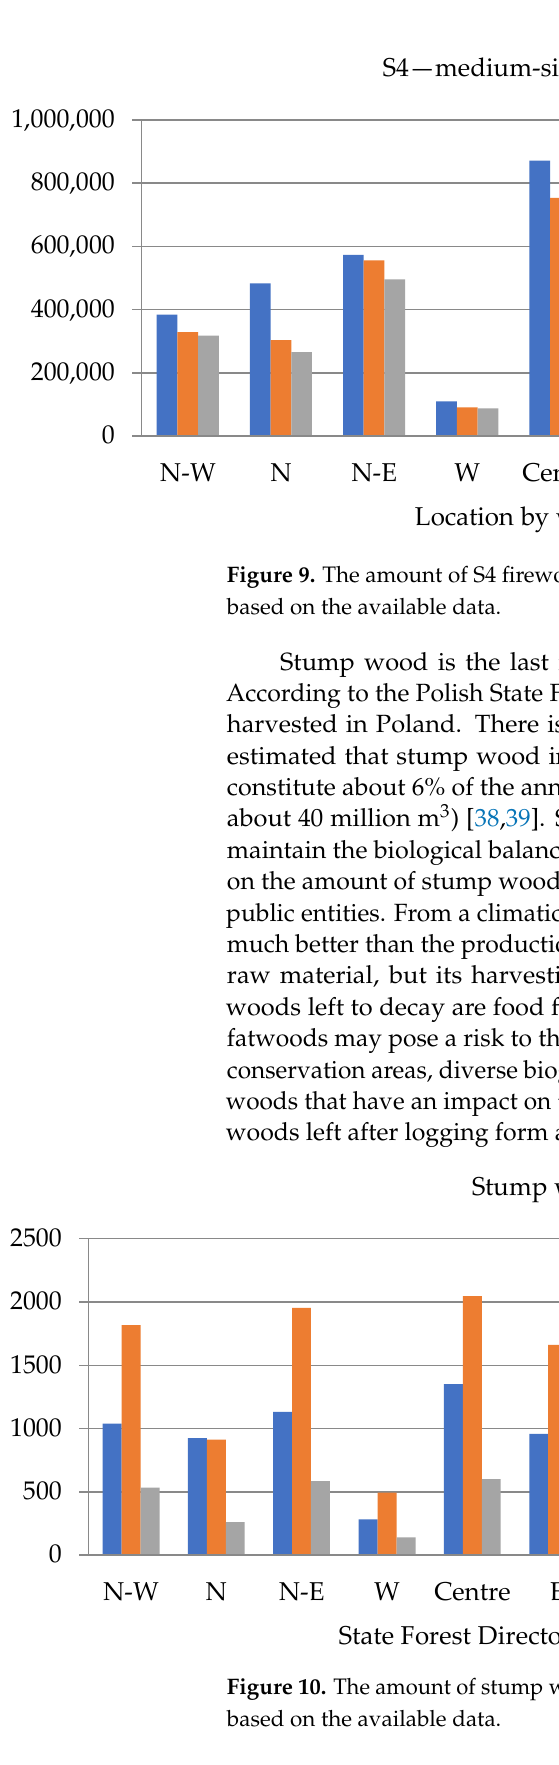
Figure 10. The amount of stump wood harvested in Poland between 2018 and 2020. Own elabora- tion based on the available data.